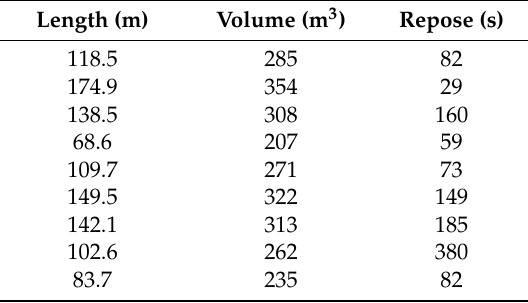
Table 1. Slug length and repose time data associated with rapid strombolian activity in the Yasur volcano (Kremers et al. [33] Table 2, note, only bursts with defined repose times are taken and this is then taken as the time between bursts) in addition to calculated explosive gas